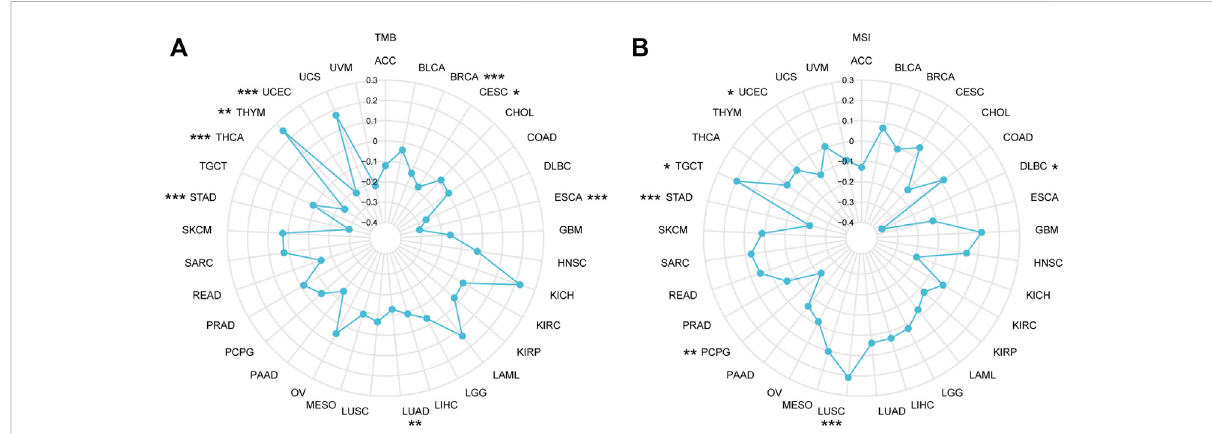
FIGURE 9 The correlations between IGSF10 expression and TMB, MSI. (A) Radar map of the correlations between IGSF10 expression and TMB in pan- cancer. (B) Radar map of the correlations between IGSF10 expression and MSI in pan-cancer. * p < 0.05, ** p < 0.01, *** p <